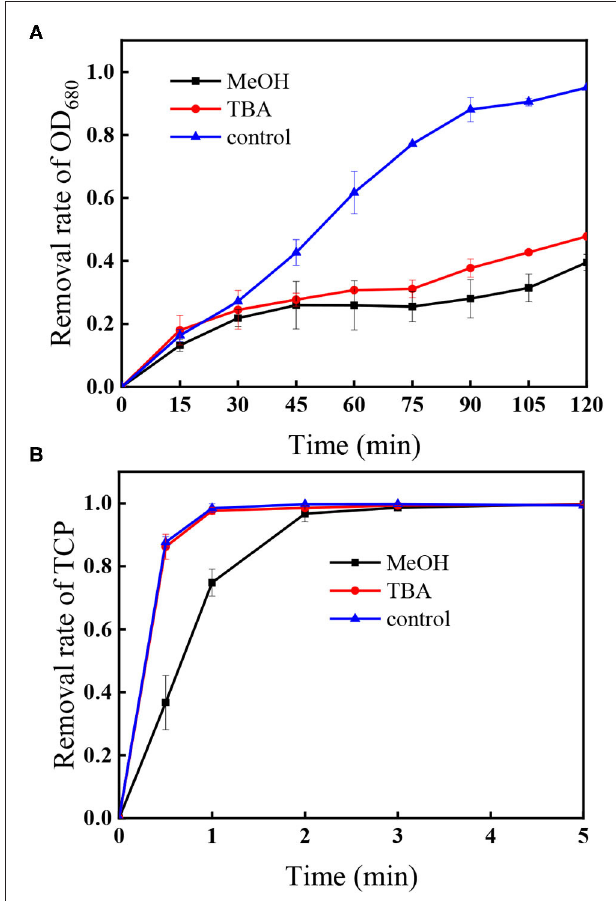
FIGURE 2 | Impacts of TBA and MeOH on the removal of (A) OD 680 and (B) TCP. Conditions: initial algal cell density: (1.00 ± 0.05) × 10 6 cells/mL, initial TCP concentration: 20 µ M, initial pH: 7.6 ± 0.2, temperature: 25 ± 1 ◦ C, UV intensity: 7.82 mW/cm 2 , PS dose: 1.5mM, [MeOH] = [TBA] = 22.5mM. The error bars represent the standard deviations from duplicate